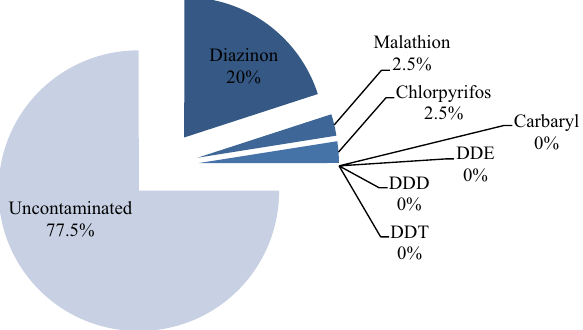
Fig. 1 Contamination status of the water samples Asterisk since, the water sample (sample no. 8) is contaminated with both malathion and diazinon residues; the percentage of water sample contamination by malathion (2.5%) is included within that of diazinon